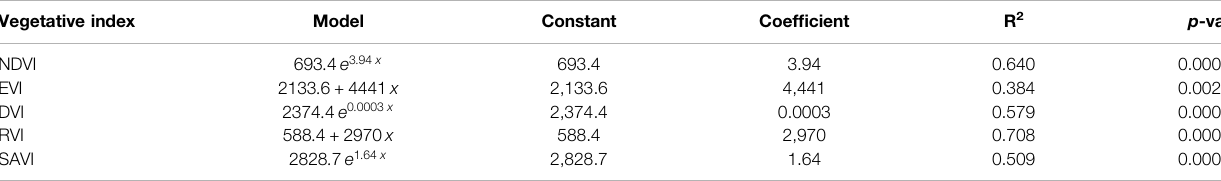
TABLE 6 | The regression model applied to estimate carbon stock in public parks (PP).